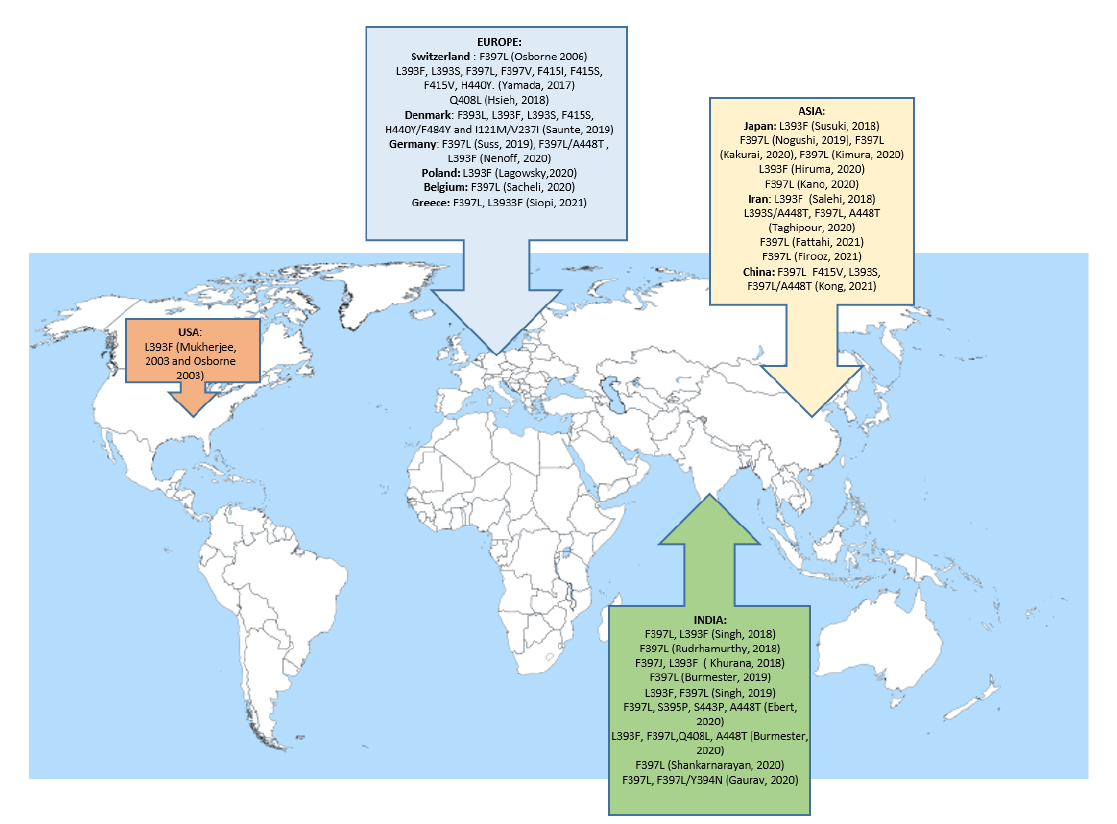
Figure 2. Geographical localization of cases of terbinafine resistance associated with mutations in SE described around the world.